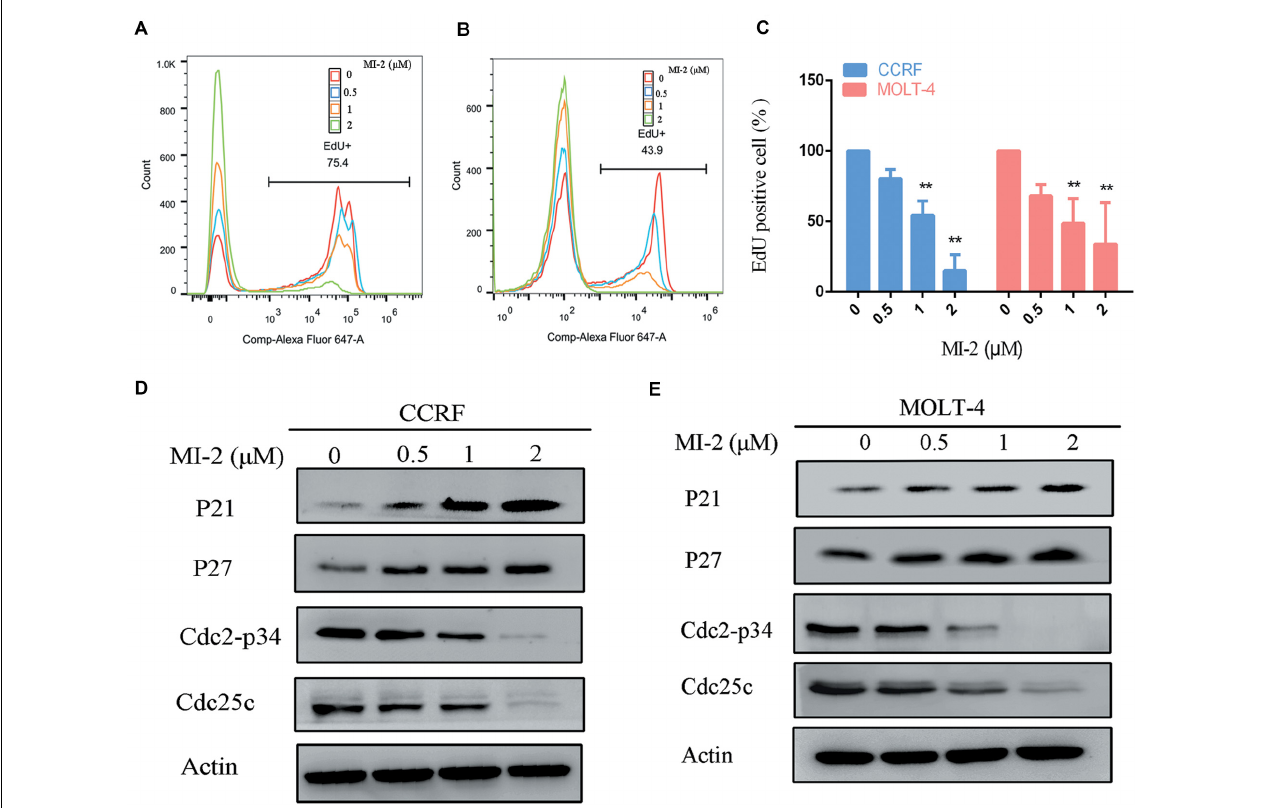
FIGURE 2 | MALT1 is associated with the proliferation of T-ALL cells. (A,B) The effect of MI-2 on proliferation was determined by FACS after MI-2 treatment. (C) The percentage of EdU positive cells was quantified in CCRF and MOLT-4. CCRF and MOLT-4 cells were treated for 12 h. (D,E) Expression of cell cycle related proteins was evaluated by western blot. ** P <